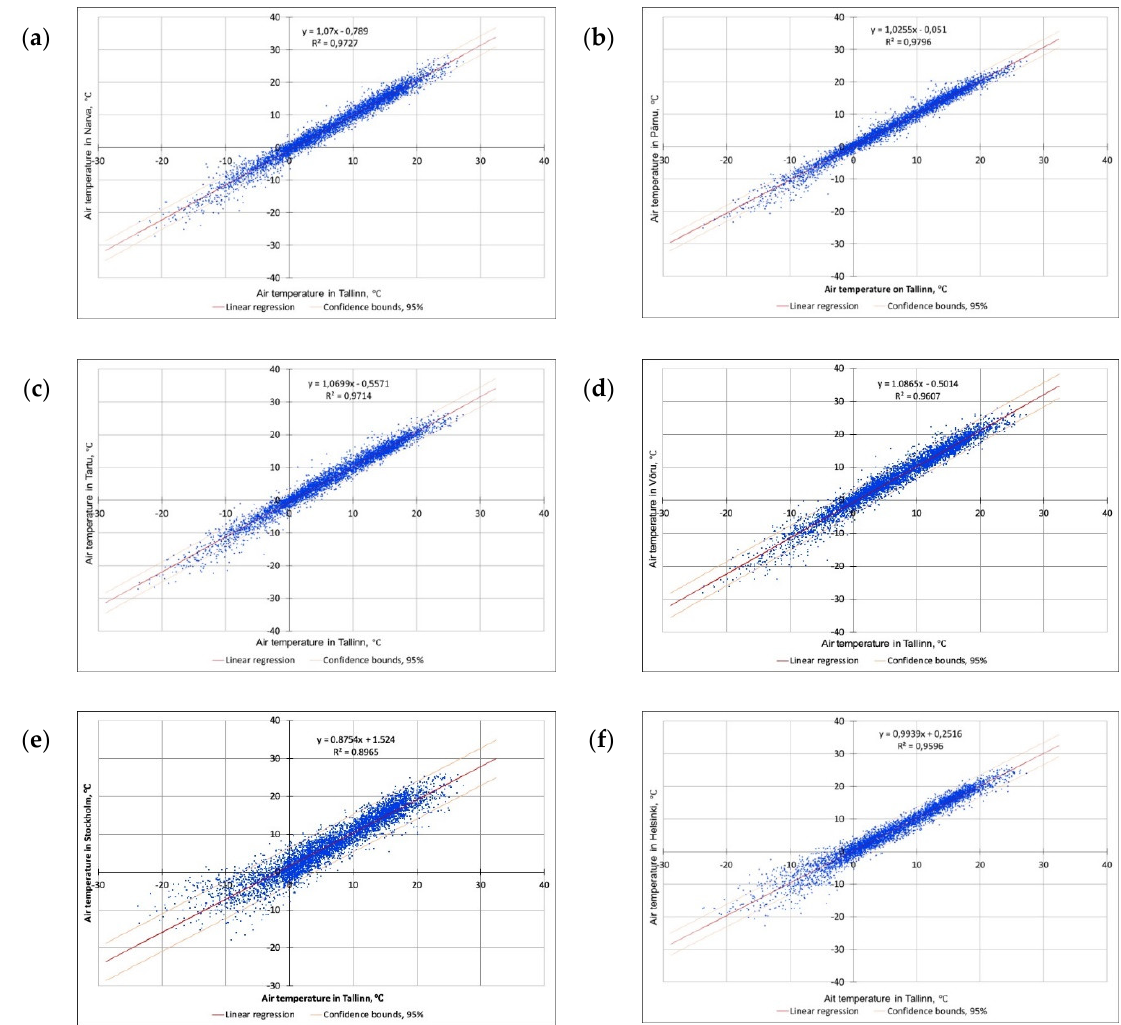
Figure 5. Correlation of average daily air temperatures in different cities with the average daily air temperature in Tallinn during the period 2005–2019 with a linear regression and 95% confidence bounds: ( a )—Narva, ( b )—Pärnu, ( c )—Tartu, ( d )—Võru, ( e )—Stockholm, and ( f )—Helsinki. Table 4. Correlations between the average daily surface air temperatures in the different cities and the average daily air temperature in Tallinn—regression parameters.